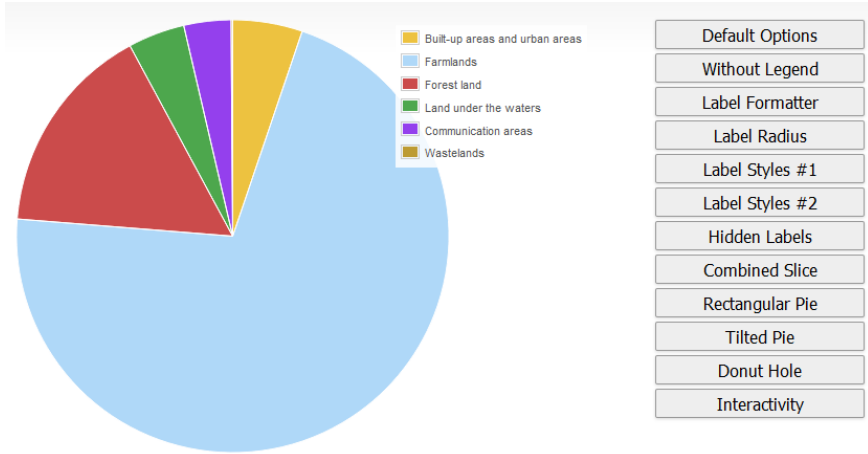
Figure 3. Interactive presentation of data using the Flot library,